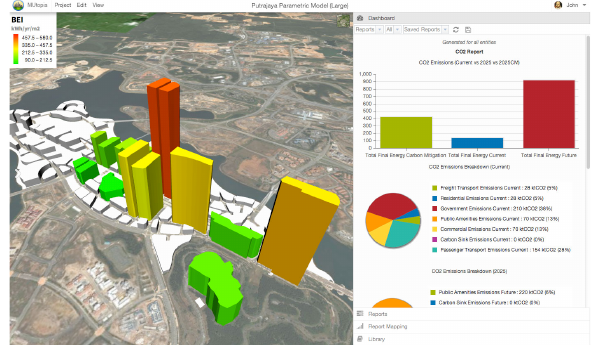
Figure 3: Prototype 3D Precinct Planning tool reporting